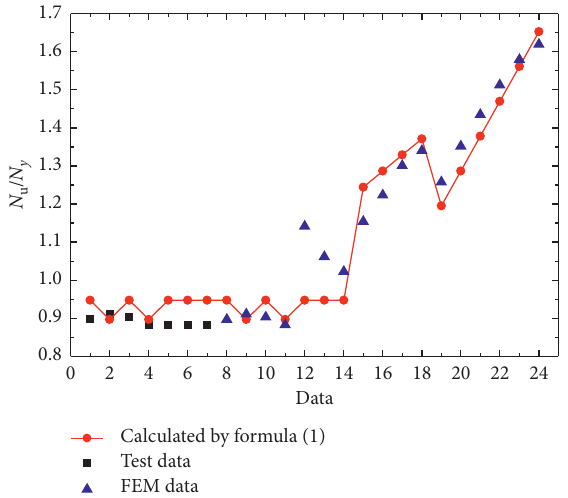
Figure 20: Results by formula (1), axially compressed test, and finite element